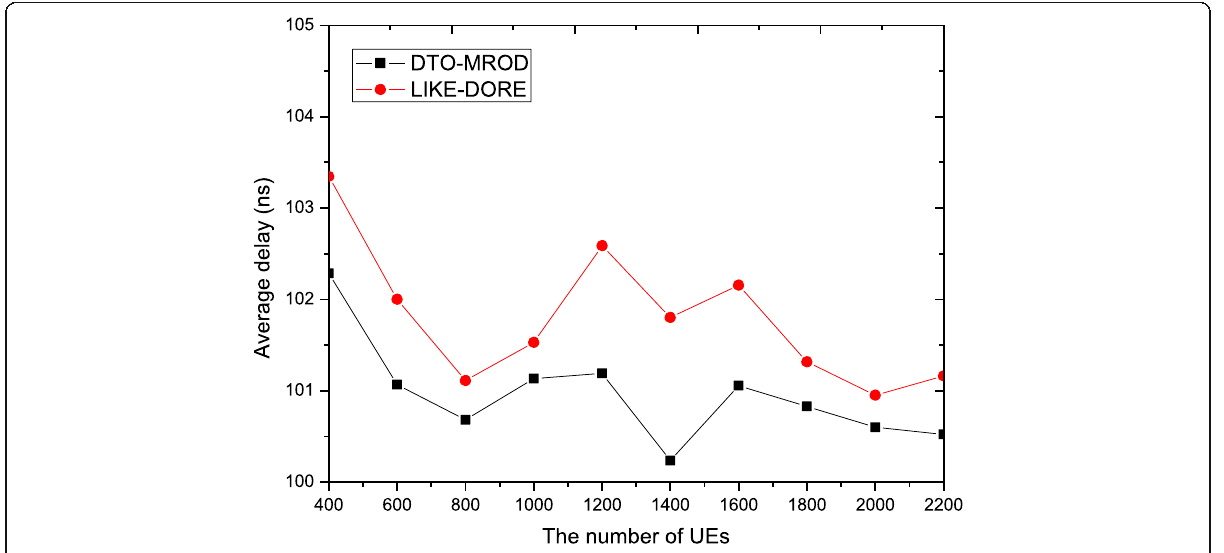
Fig. 5 Average delay for the two schemes under the different numbers of